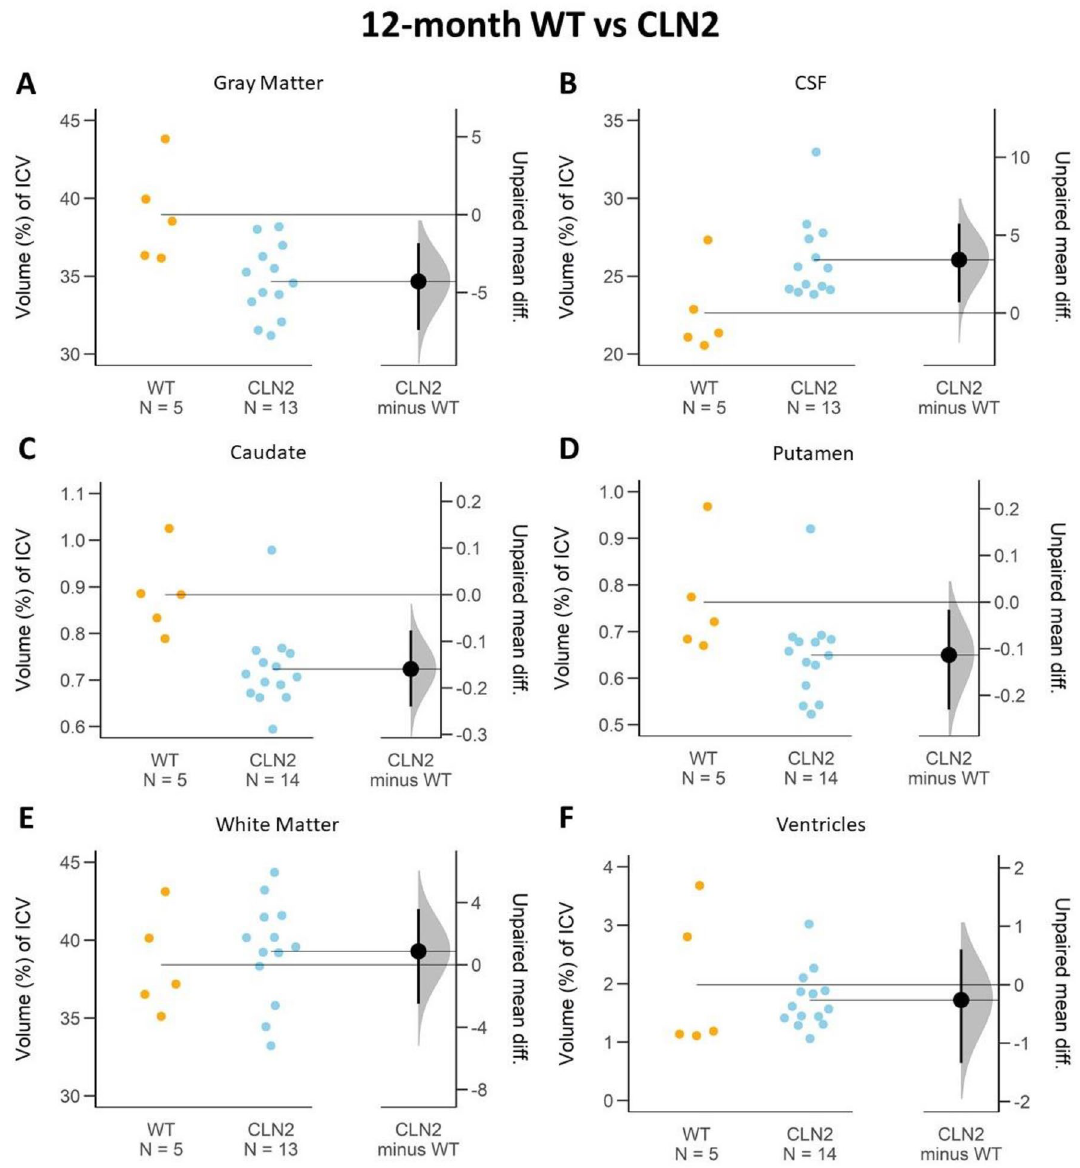
CLN2 minus WT column) do not cross the horizontal line at zero and indicate reliable measurement difference between the cohorts in gray matter ( A ), CSF ( B ), caudate ( C ), and putamen ( D ). When the average difference and 95% confidence intervals (black circle with error bar in CLN2 minus WT column) cross the horizontal line at zero as it does for white matter ( E ) and ventricles ( F ), an effect size equal to zero is possible, and reliable measured difference is